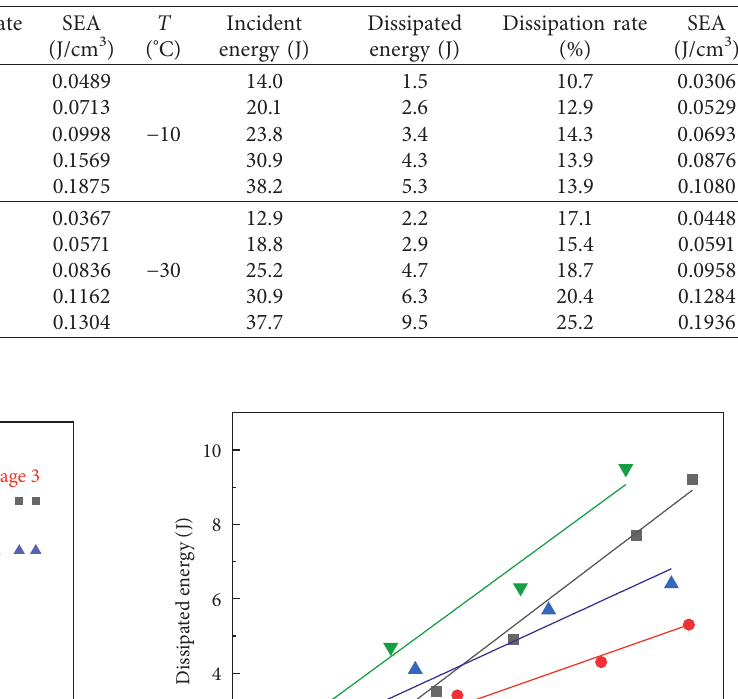
Table 4: Summary of energy calculations.